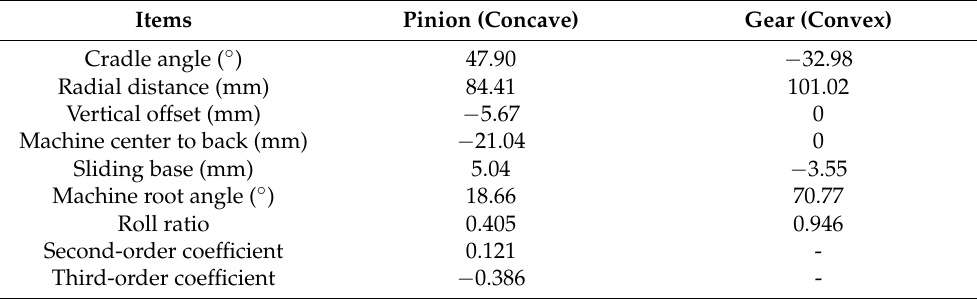
Figure 4. Key performance indexes based on control parameter optimization. ( a ) Entertainment speed; ( b ) Relative sliding velocity; ( c ) Friction coefficient; ( d ) Transmission efficiency; ( e ) Fitness values of PSOGSA algorithm. Table 2. Optimal machining parameters based on control parameter